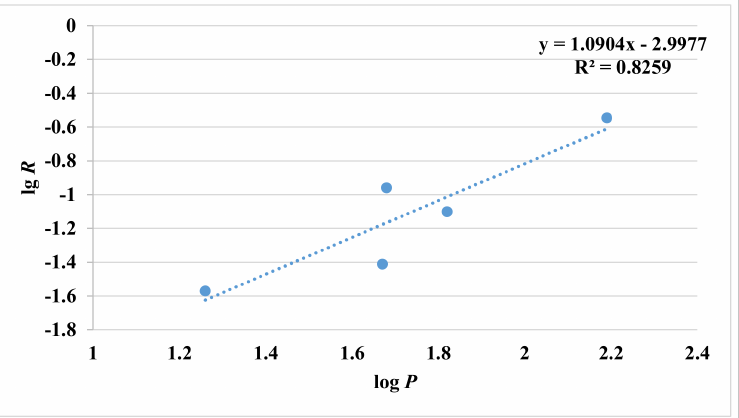
Figure 5. Relationship between logarithmic value of R values and log P of five retained esters in 1 g/L of CA